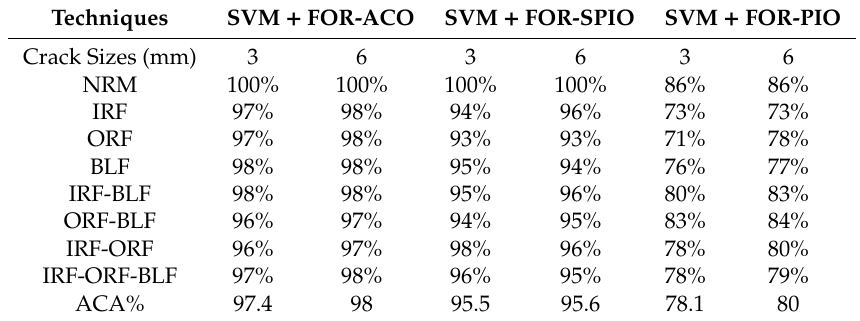
Table 11. The Accuracy of Multi-Type Fault Identification When the Torque Speed is 400 RPM. Techniques